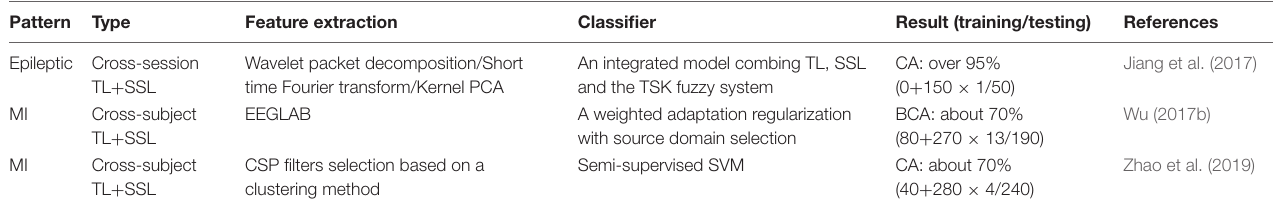
TABLE 4 | Summary of representative TL + SSL